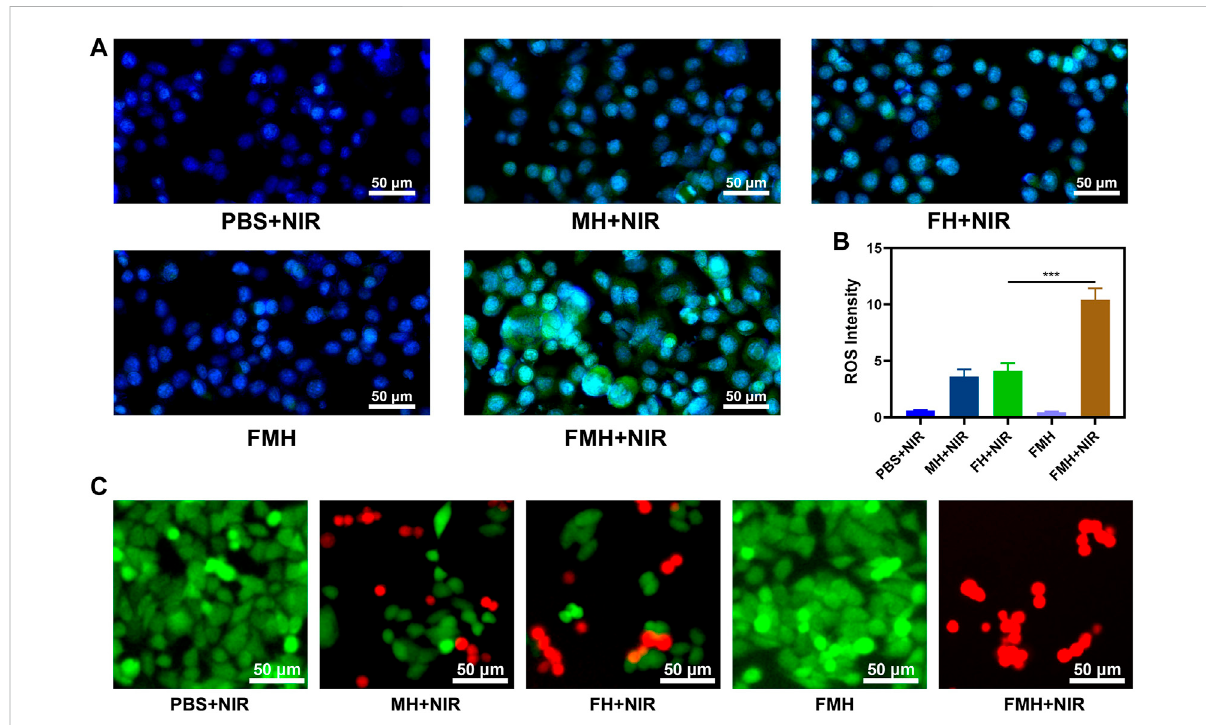
FIGURE 4 (A) Confocal laser scanning microscopy images of ROS generated in 4T1 cells after different treatments. (B) Quantitative analysis of ROS production in (A) . (C) Fluorescence images of 4T1 cells stained with fl uorescein diacetate (FDA; live cells, green fl uorescence) and propidium iodide (PI; dead cells, red fl uorescence) after incubation with different formulations. *** p < 0.005; Student ’ s